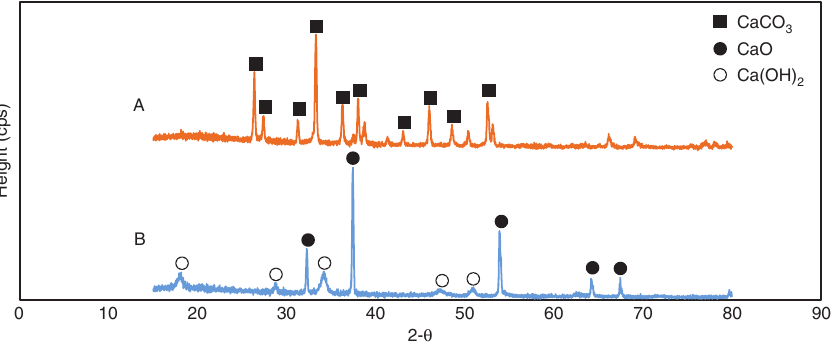
Figure 3: X-ray diffraction (XRD) patterns of (A) natural razor clam shell and (B) calcined shell.